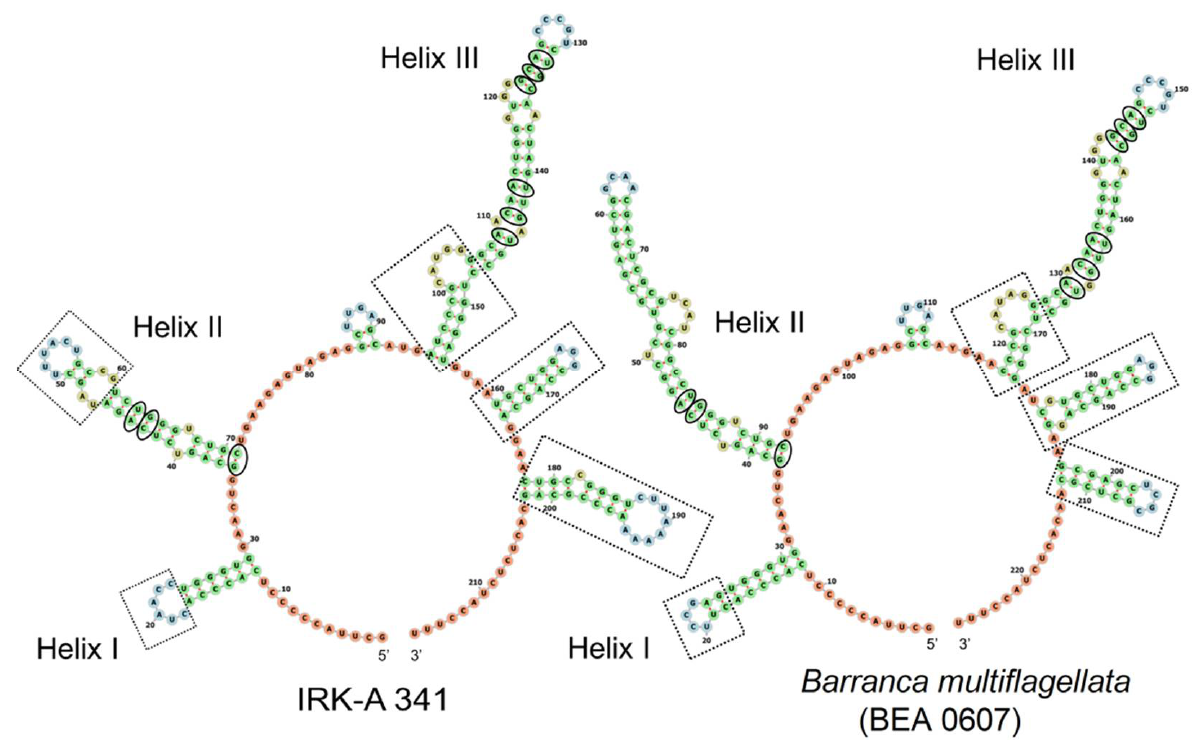
Figure 3. ITS2 secondary structures of Barranca strains. Regions (tips of Helices I and II, basal part of Helix III and two additional helical structures) which are variable between the studied strain IRK–A 341 and Barranca multiflagellata BEA 0607 are highlighted with dotted lines. Count of nucleotide positions starts from 5 (cid:48) end of ITS2. Common for Chlorophyta sites of CBC in conservative parts of Helixes II and III are ringed (no specific CBCs in Barranca ). Structures with minimum free energies (dG) − 37.05 for IRK–A 341 and − 58.27 for BEA 0607 were compared.